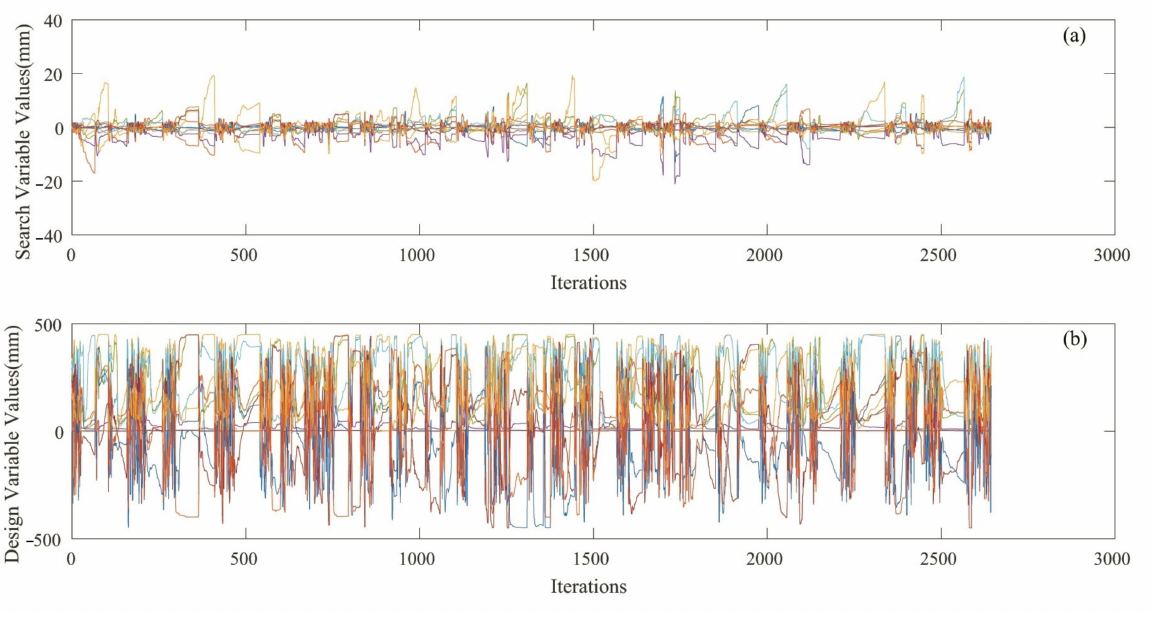
Figure 8. ( a ) Search variables over the entire run of QNM-based optimization process, and ( b ) design variables over the entire run of QNM-based optimization process.